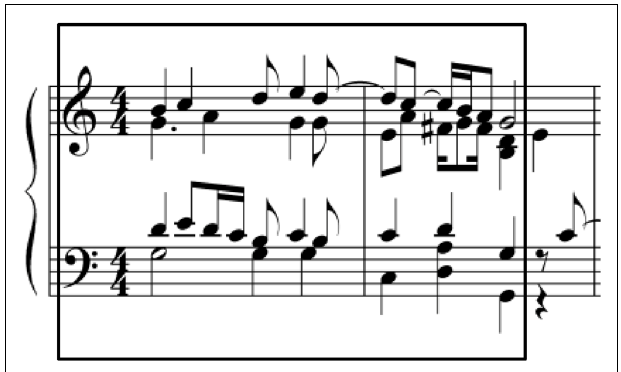
FIGURE 2 | Excerpt from Frescobaldi’s Partita used in the sorting task. The boxed section corresponds to the fragment heard by participants.